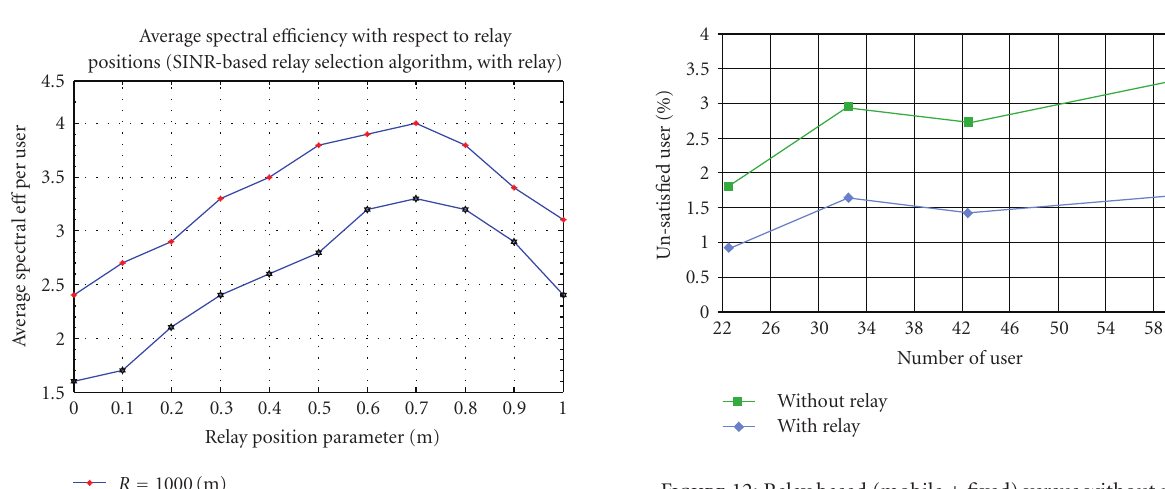
Figure 12: Relay based (mobile + fixed) versus without relay.